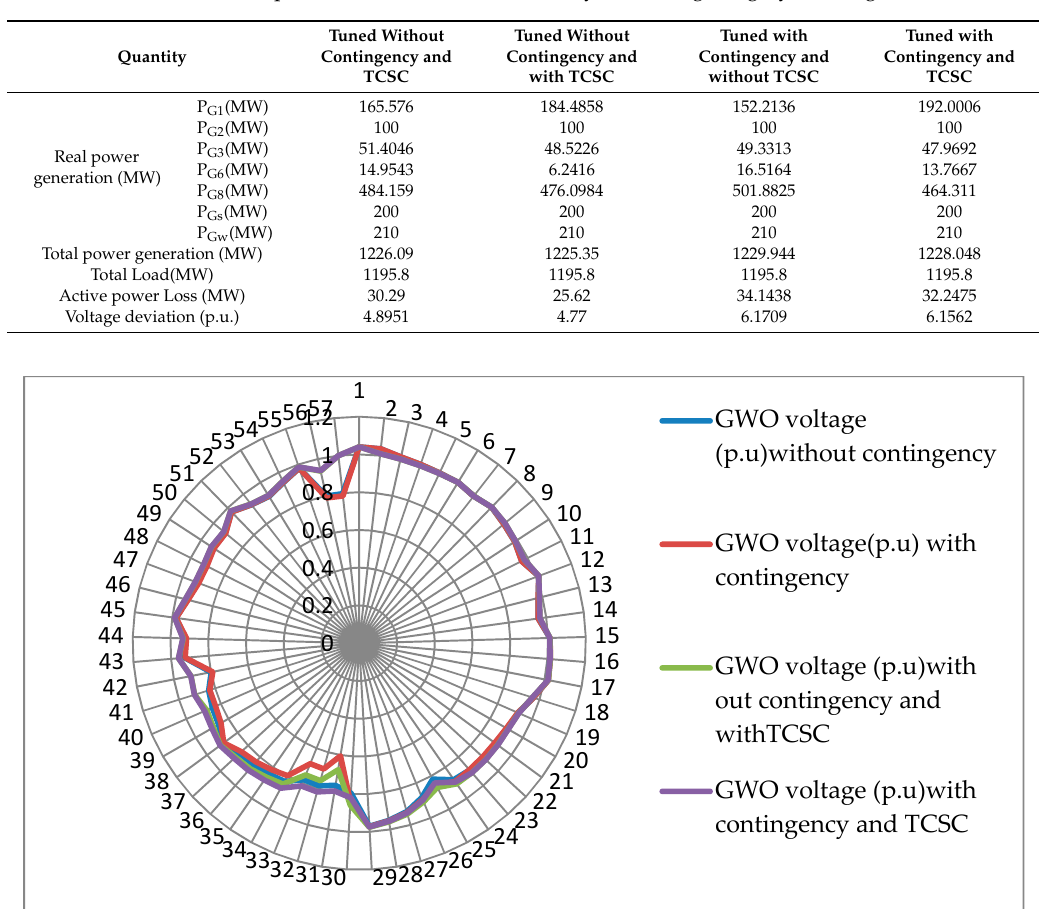
Table 10. Optimal power flowsolution with contingency and TCSC using GWO. Parameter